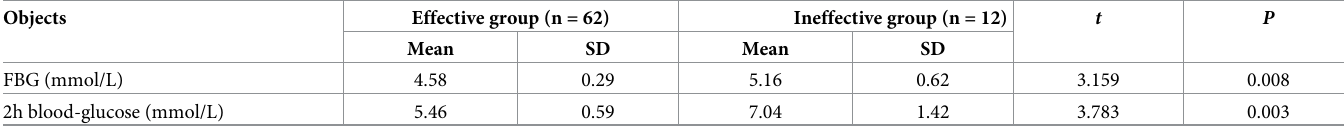
FBG: Fasting blood glucose.